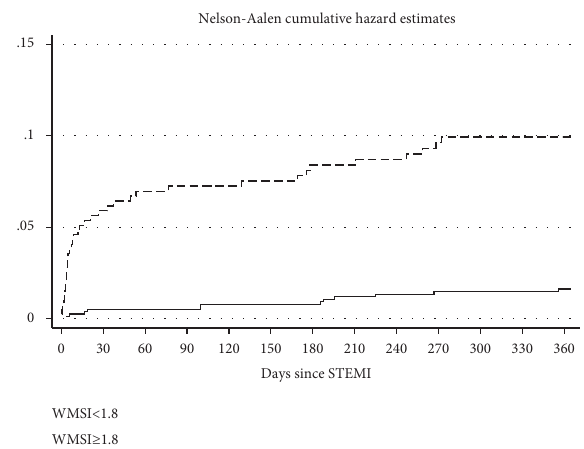
Figure 2: Nelson-Aalen cumulative hazard estimates by subsets indicated demonstrating signifcantly poorer survival for WMSI ≥ 1.8 when compared to WMSI < 1.8. WMSI–Wall motion score